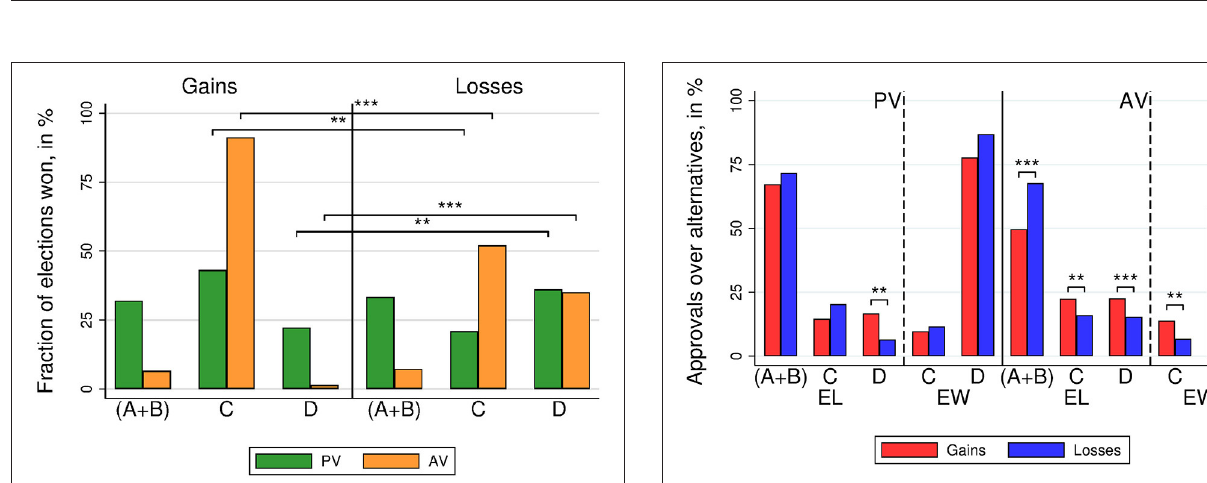
FIGURE 2 | Society 1. Left : Number of approvals by treatment and group of voters. Right : Distribution of the number of approvals by treatment and group of voters. Stars refer to the significance of non-parametric tests ( ∗∗∗ p < 0.001).